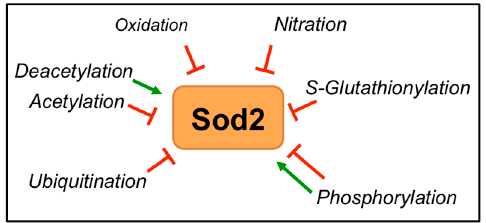
Figure 4. SOD2 post-translational regulation. Most modifications, besides phosphorylation, render the enzyme inactive. De-acetylation by SIRT enzymes is a common regulation of SOD2 activity in response to redox and nutrient stress.